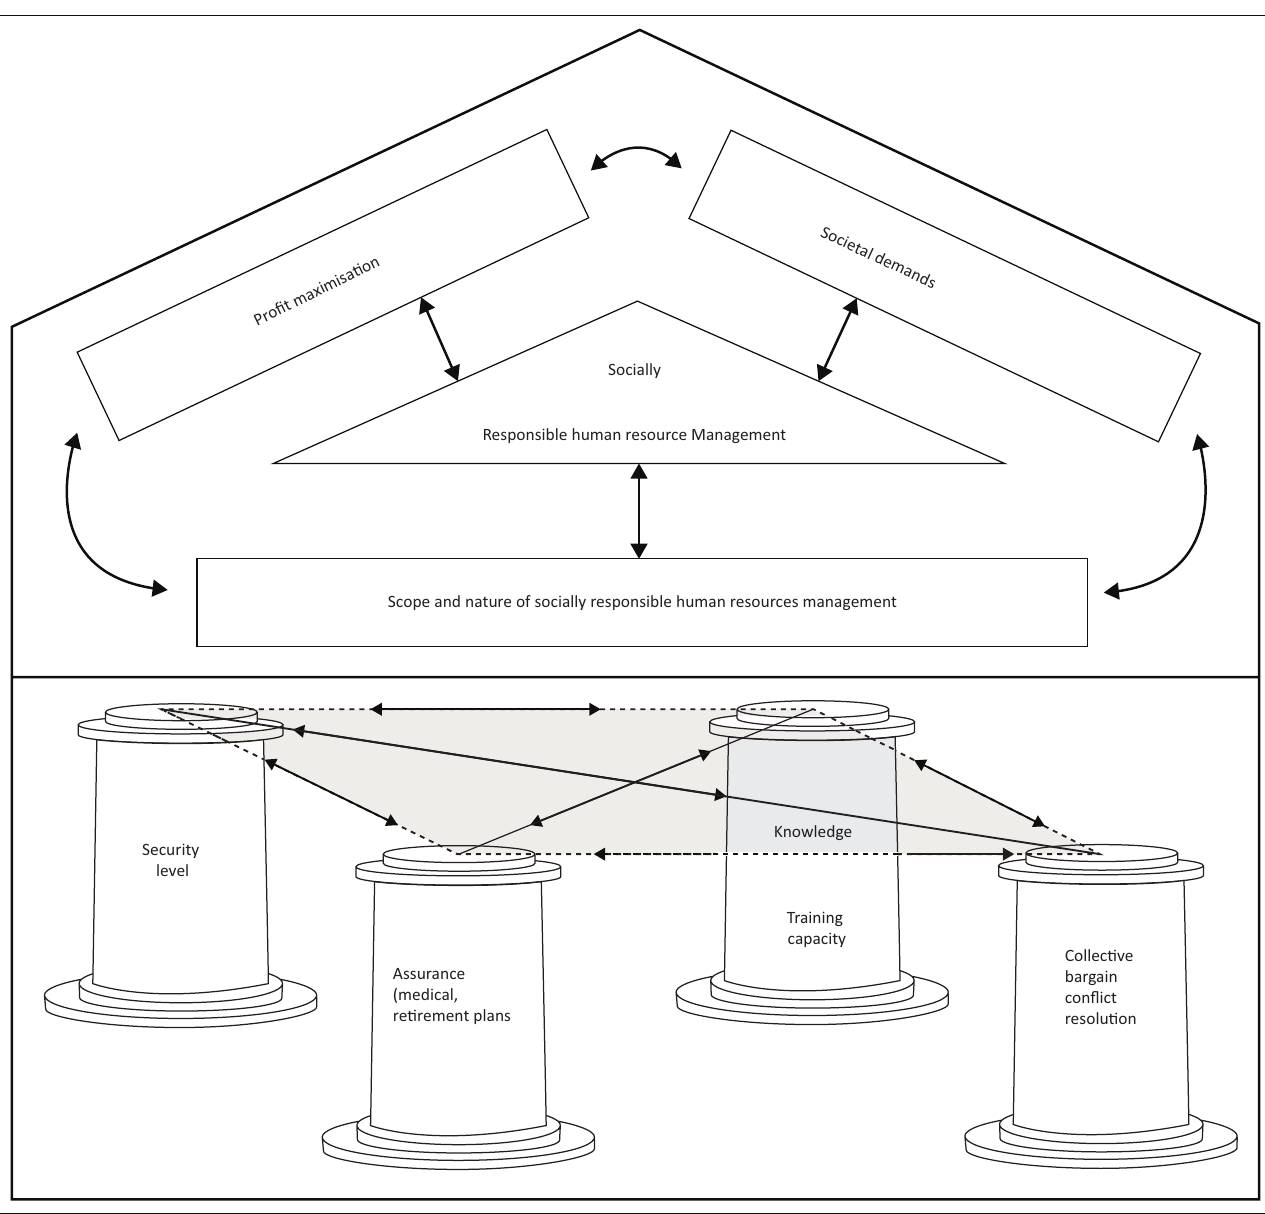
FIGURE 1: Critical aspects assessed in the socially responsible human resources